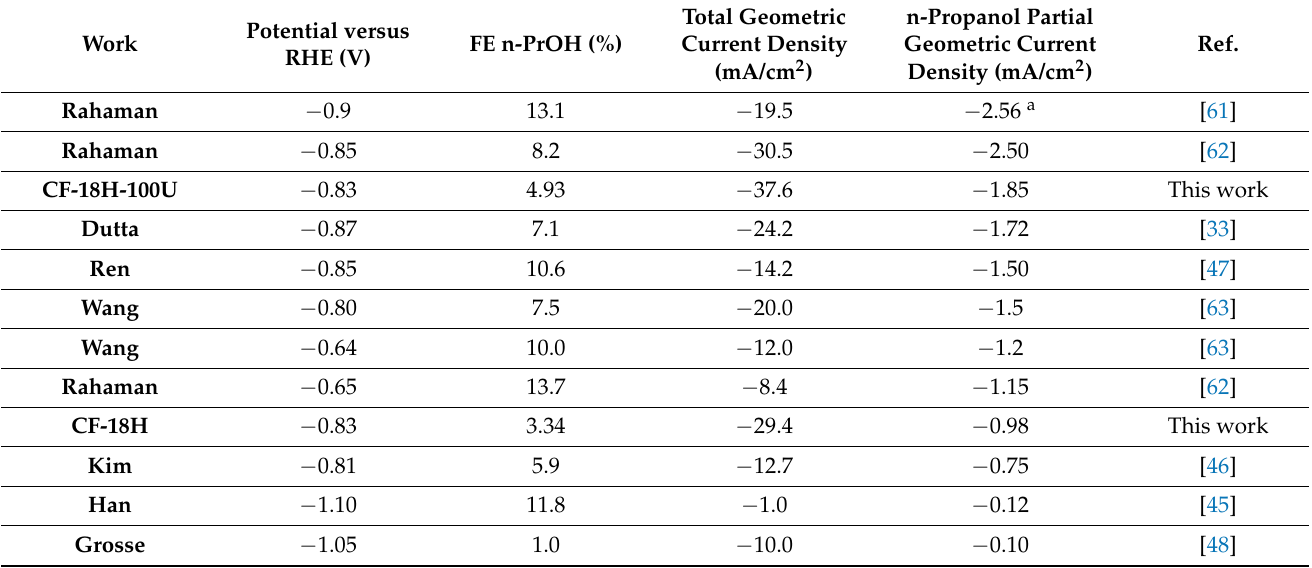
Table 2. A comparison of the best faradaic efficiencies (FE) and geometric current densities reported in the literature for the electroreduction of CO 2 to n-PrOH (entries ordered by n-propanol partial geometric current density). Work